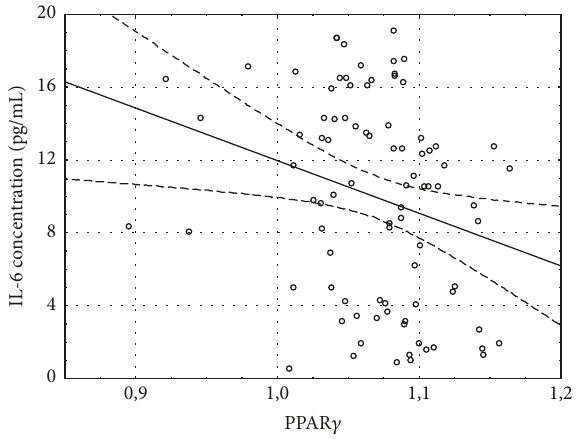
Figure 5: Significant negative correlation between serum IL6 level before CABG and expression of PPAR 𝛾 ( 𝑅 = −0.31 , 𝑝 < 0.05 ) was observedonlyinpatientsinwhomlaterinthefollow-upheartfailure was